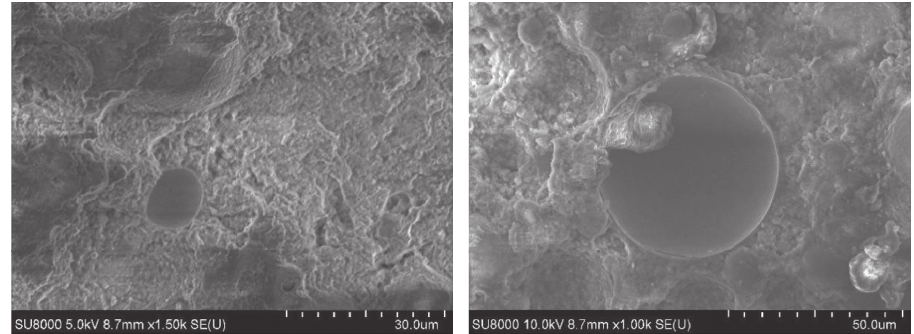
Figure 2: Micromorphology of low-density cement